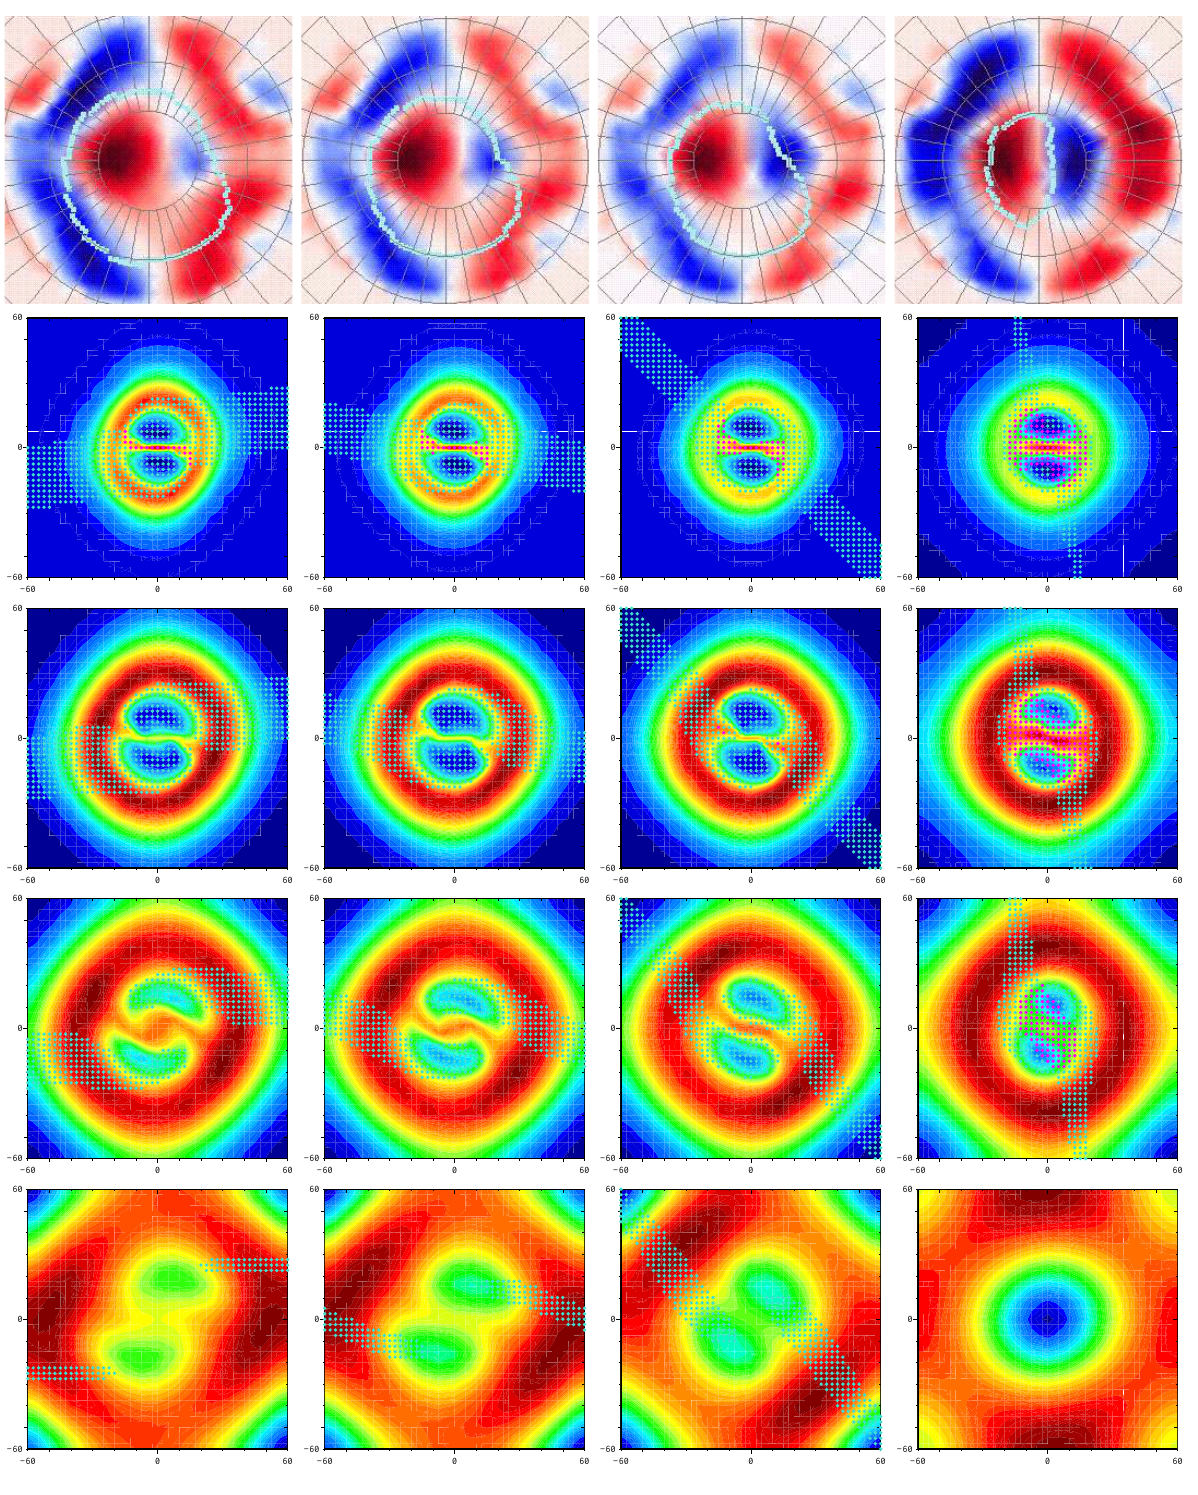
Fig. 2. Simulation results for an MHD run with positive IMF B z of + 5nT and a fast (2min) IMF B y sign change from − 5nT to + 5nT after two hours constant IMF (run 2a). The columns (from left to right) show the state of the magnetosphere − 8 , 7 , 22 and 37min after the center of the IMF B y sign-change region ( B y = 0) has passed the dayside magnetopause (at x = 10 R E ). The first row shows the northern ionosphere. The second to last row show tail cross sections at x =− 10, x =− 30, x =− 60 and x =− 90 R E . The plots are defined in the same way as in Fig.